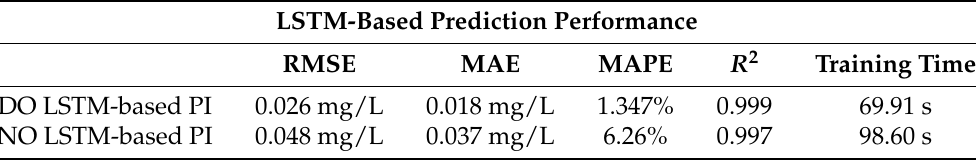
Table 1. Prediction performance of the DO LSTM-based PI and the NO LSTM-based